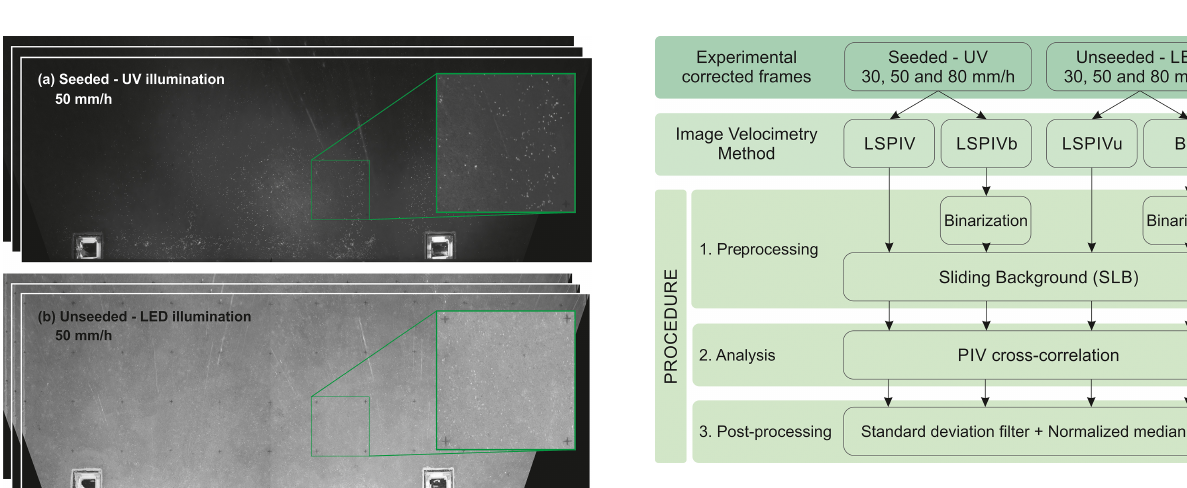
Figure 1. General image of the urban drainage physical model with the rainfall simulator (a) and experimental setup of the PIV experi- ments (b) .